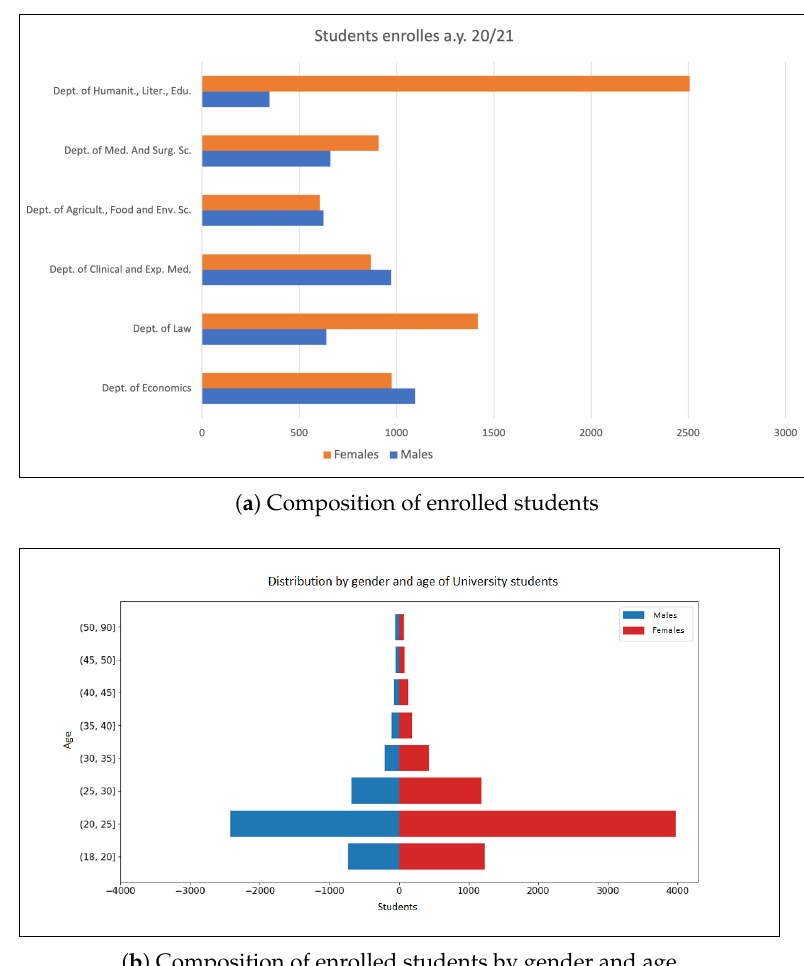
Figure 5. Composition of total